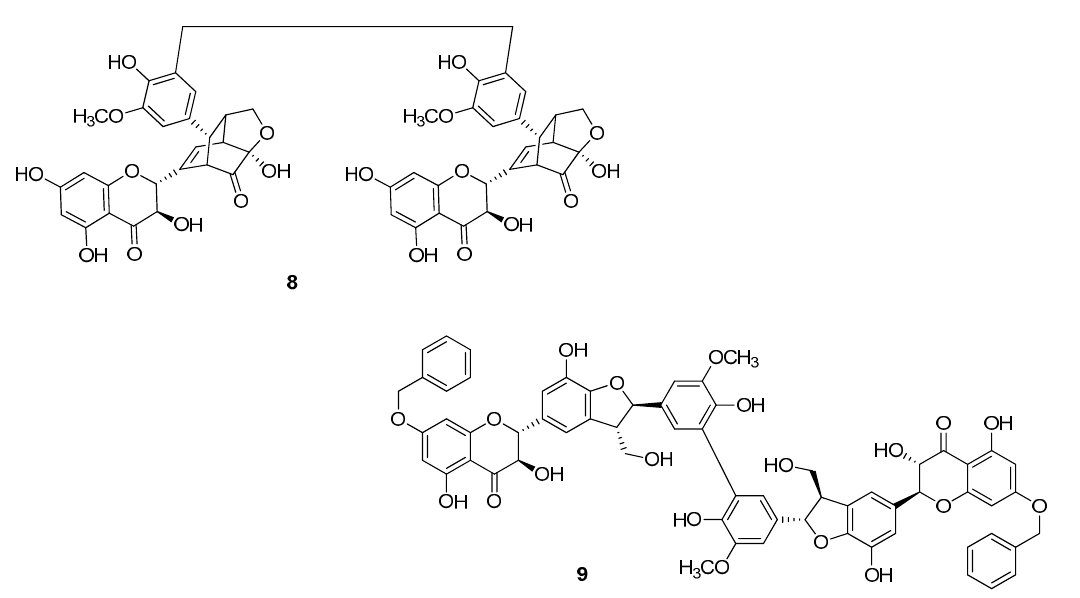
Figure 5. Bi -flavonolignans from silydianin ( 8 ) and silychristine ( 9 ) oxidation.